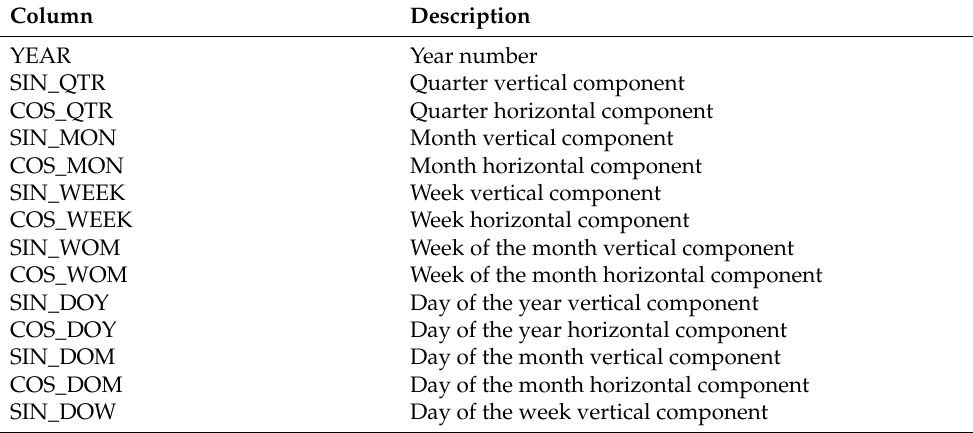
Table 3. Cyclic time feature